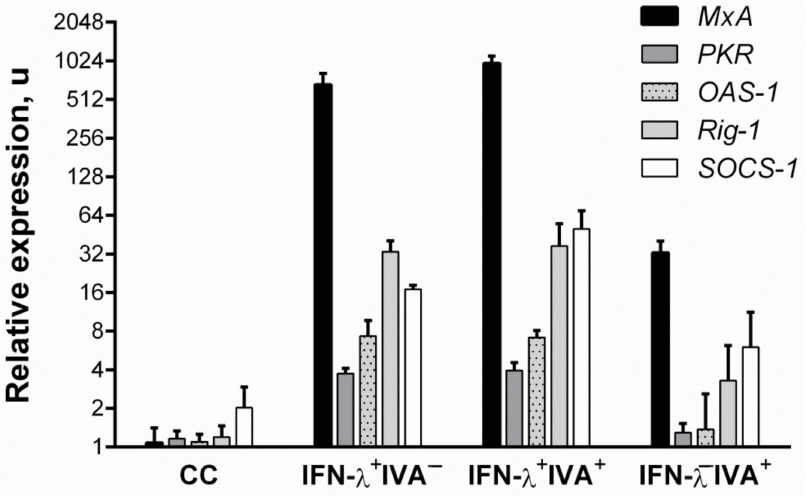
Figure 2. Interferon-stimulated gene mRNA patterns, in response to IFN- λ 1 and IVA stimu- lation, 24 h after treatment . A549 cells were used. CC—cell control; IFN- λ + IVA – —uninfected cells stimulated with IFN- λ 1 at 500 ng/mL; IFN- λ + IVA + —cells infected with A/California/07/09 (H1N1pdm09) at 1 MOI and then stimulated with IFN- λ 1 at 500 ng/mL; IFN- λ − IVA + —cells infected with A/California/07/09 (H1N1pdm09) at 1 MOI. Values are marked as mean ±